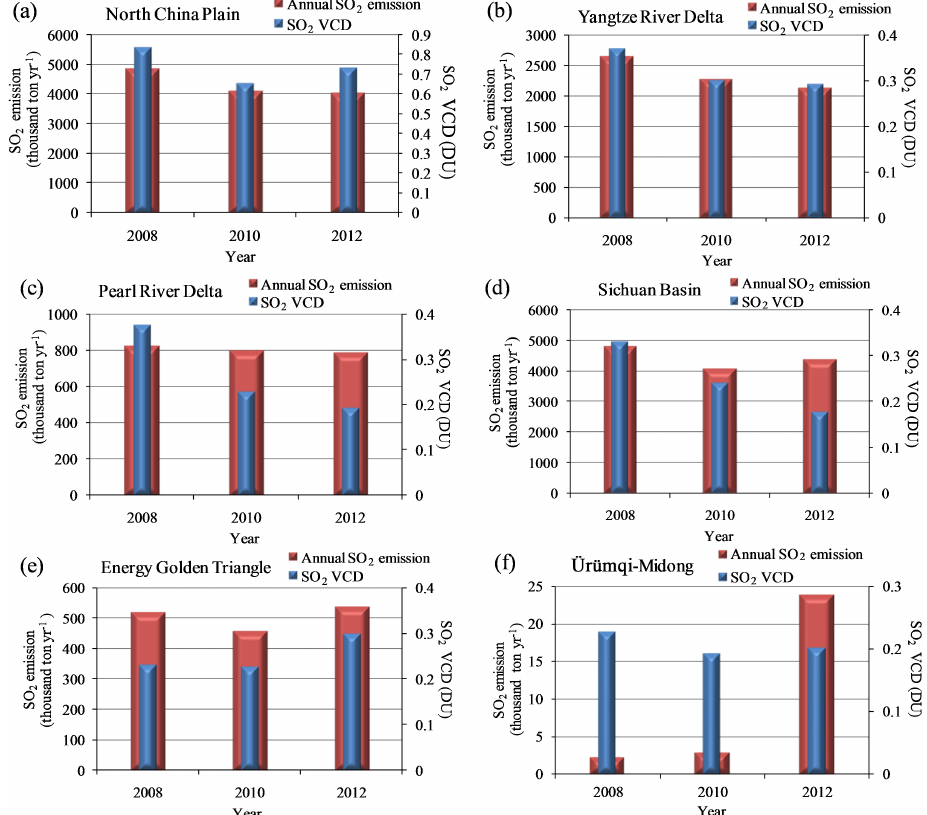
Figure 3. Annually averaged SO 2 VCD (DU), scaled on the right-hand-side y axis, and annual emissions (1000tyr − 1 ) of SO 2 , on the left-hand-side y axis, in the NCP, YRD, PRD, Sichuan Basin, EGT, and Ürümqi–Midong